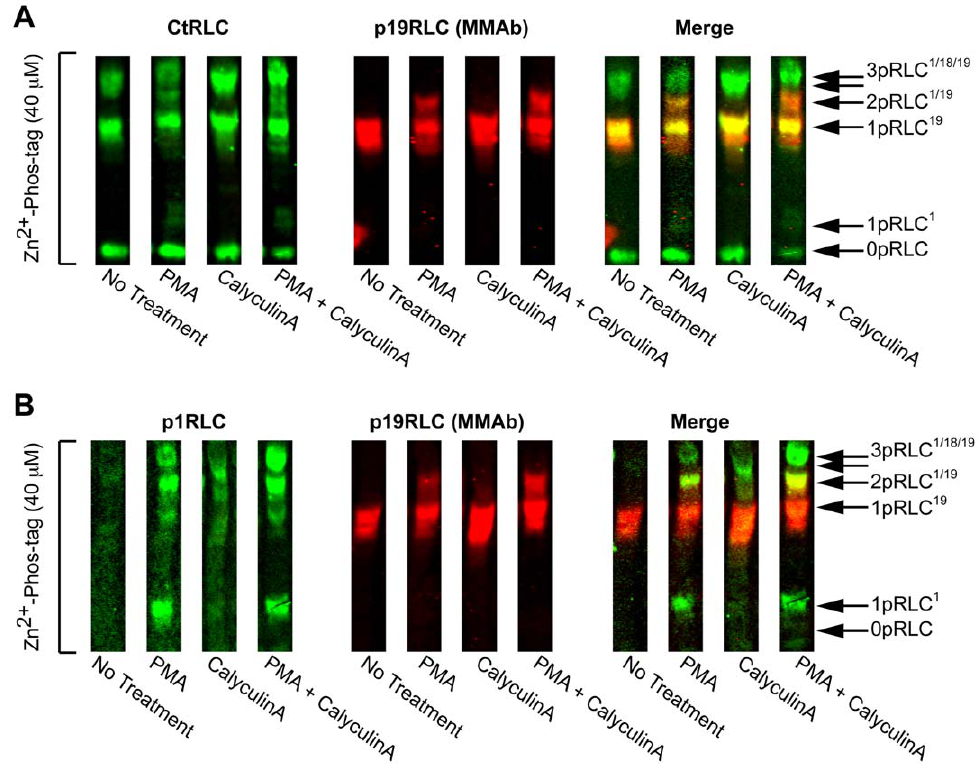
Figure 7. Advanced phos-tag analysis of phosphorylated RLC in PMA-treated uterine myocytes. A and B. WBs produced by Zn 2 + -phos- tag (40 m M) separation of lysates from untreated samples, or samples treated with PMA (1 m M), CalyculinA (20 nM), or with both. In both A and B, the red signal corresponds to a mouse monoclonal Ab (MMAb) targeting p19RLC that is detected independently of the green signals (CtRLC in panel A, and p1RLC in panel B). A yellow signal indicates overlap of the individual green and red signals. 0pRLC, 1pRLC, 2pRLC and 3pRLC denote non-, mono-, di-, and tri-phosphorylated RLC. The superscripts denote the position of the phospho-modification: 1: S1, 18: T18, 19: S19. The unlabeled arrow below 3pRLC 1/18/19 corresponds to 2pRLC 18/19 that is particularly prominent in lysates treated with CalyculinA alone.